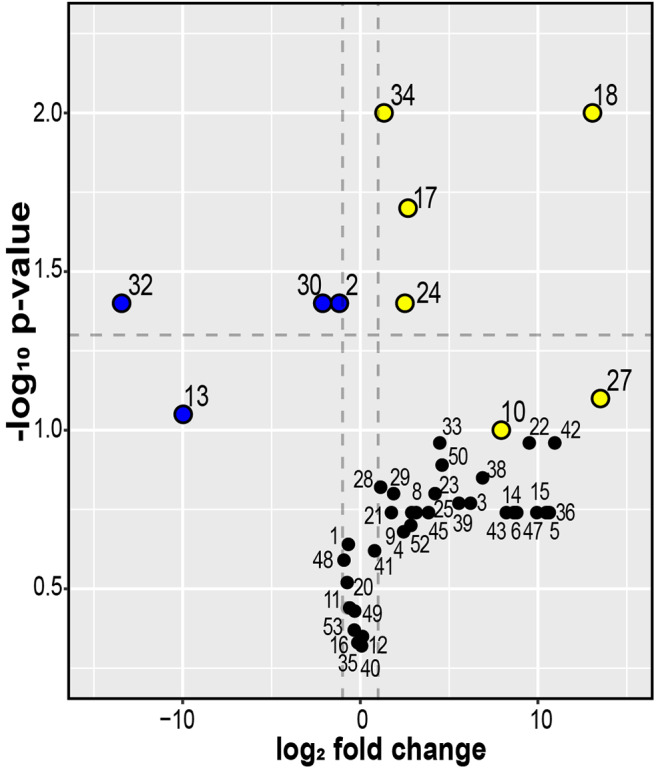
Volcano plot of the log2 fold-change difference in VOC abundance for MWU328 relative to MWU328W in monocultures. Dashed lines indicate p < 0.05 and log2 fold change > 1 or < −1. Metabolites in blue or yellow are more abundant in the mutant or wild type, respectively (p < 0.1). The fold-changes and p-values are provided in Supplementary Table 3. Compound IDs: 2 = dimethyl disulfide; 10 = 1,2-Ethanediol, diacetate; 13 = N-13; 17 = 1-Octanol; 18 = CA-18; 24 = Octanoic acid; 27 = UNK-27; 30 = ETH-30; 32 = Indole; 34 = EST-34.